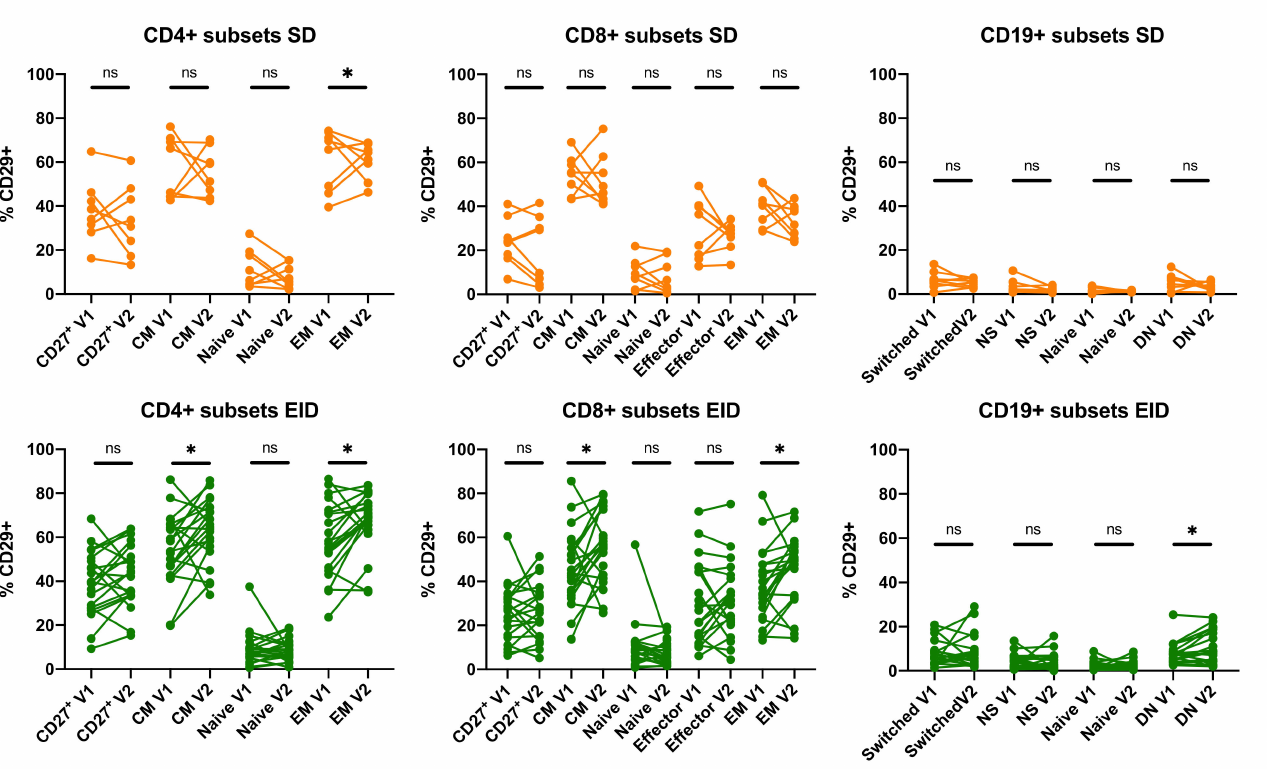
Figure 5. Comparison of first (V1) and second (V2) extractions within CD4 + and CD8 + T lymphocytes, and CD19 + B lymphocytes subpopulations in RRMS patients under Natalizumab treatment in SD or EID. Percentage of expression of CD29 in all CD4 + and CD8 + T lymphocytes, and CD19 + B lymphocytes subsets. Each dot represents the percentage of expression of CD29 regarding their parent population (CD4 + or CD8 + T lymphocytes, or CD19 + B lymphocytes populations) in the SD ( n = 8) and EID ( n = 21) groups. CM, Central Memory; DN, Double Negative; EID, extended interval dosing; EM, Effector Memory; NS, Non-Switched; SD, standard dosing. Ns: p > 0.05, * p <